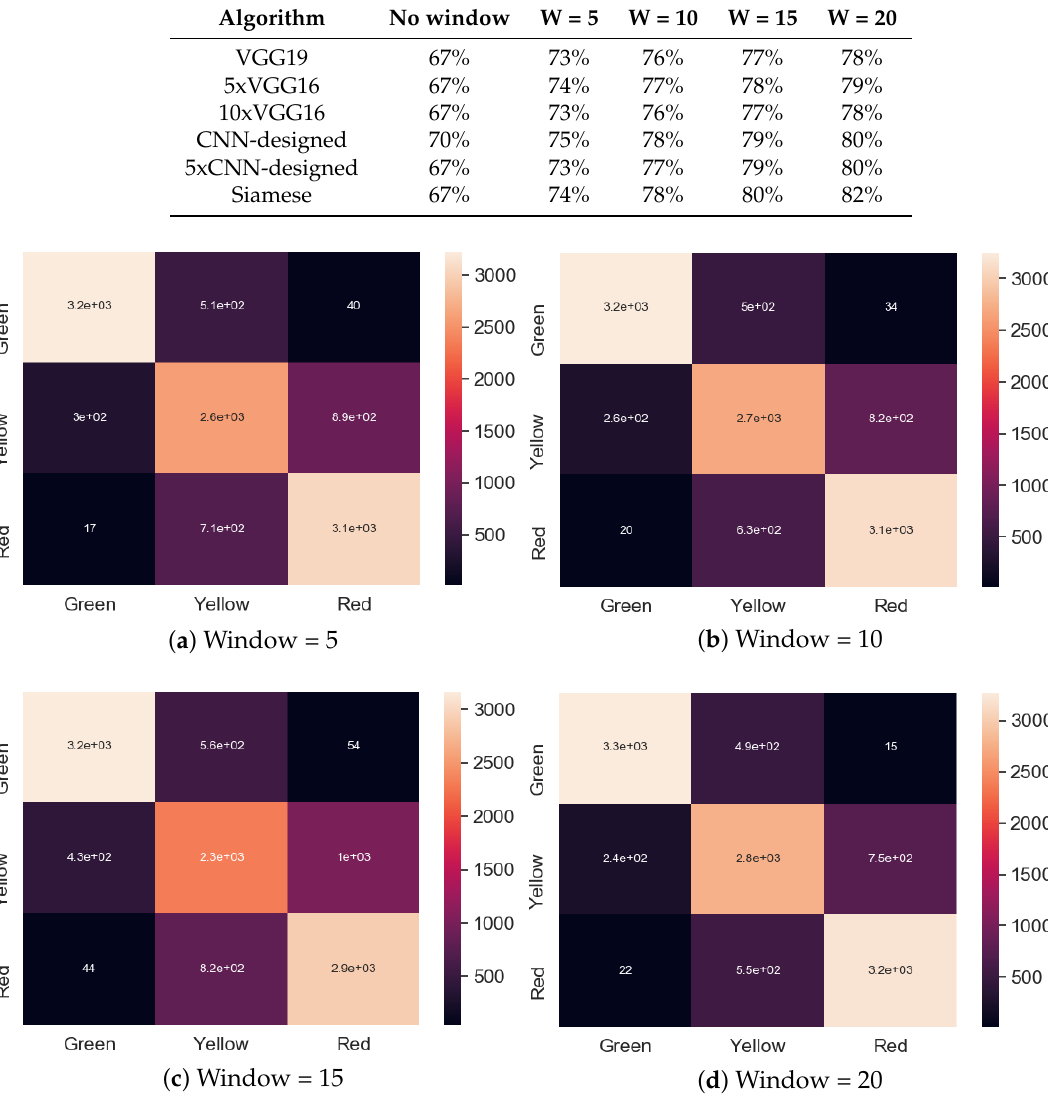
Table 3. Classification results for the chosen algorithms, for classification with no window and with different window sizes (5, 10, 15, and 20) for consecutive samples.